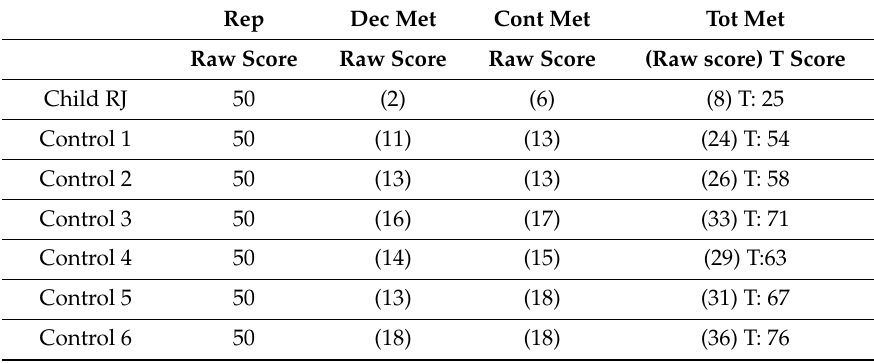
Table 2. RJ’s scores on metaphor comprehension (Junior Metaphor Comprehension Test (Junior